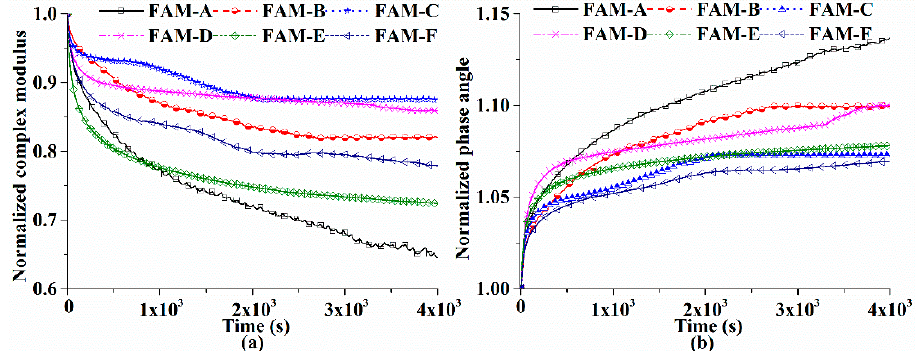
Figure 11. Normalized curves for fatigue tests at 25 ◦ C: ( a ) the normalized complex modulus (( | G * | ), and ( b ) the normalized phase angle ( ◦ ).